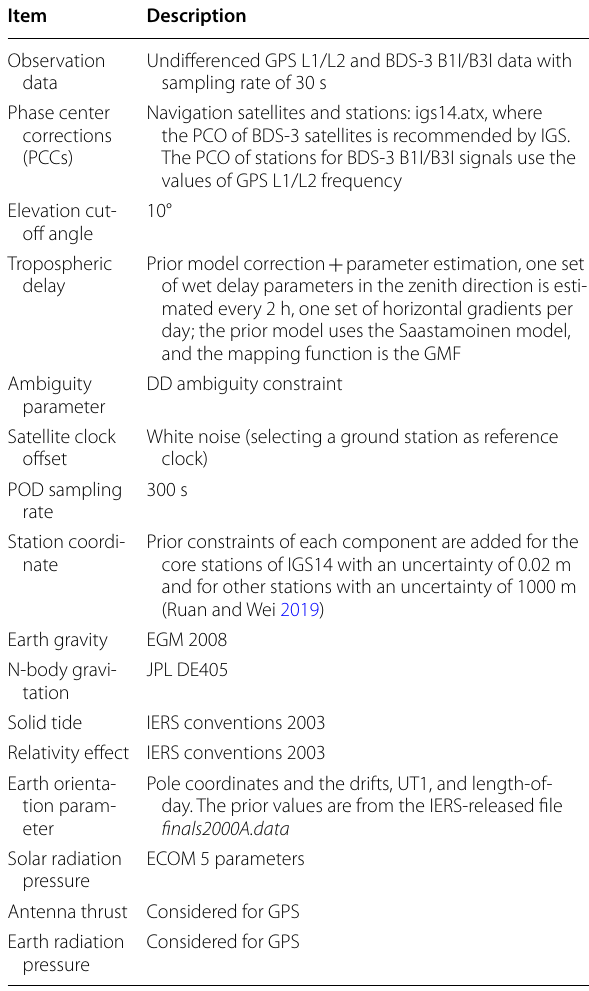
Table 1 Processing strategy for POD